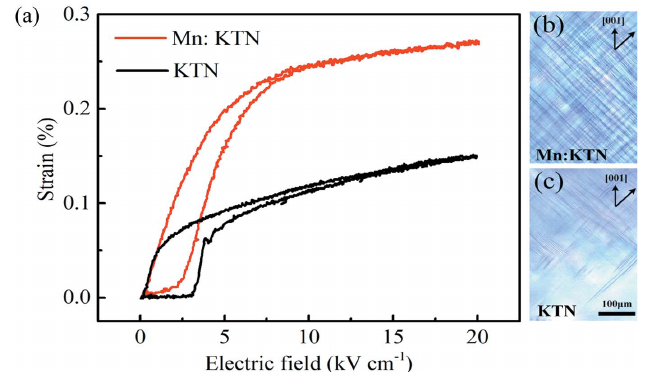
Figure 1 Electric field-induced strain. ( a ) Unipolar strain curves and polarized light microscopy images at 25 (cid:4) C of ( b ) Mn-doped KTN and ( c ) pristine KTN, respectively.